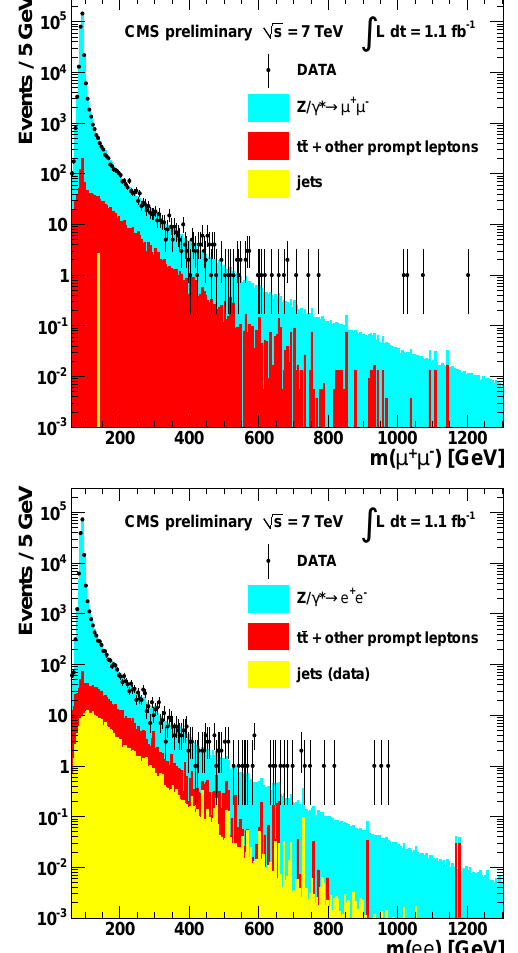
Fig. 3. Invariant mass spectrum of µ + µ − (top) and ee (bottom) events. Data is represented by points with error bars. The uncer- tainties on the data points (statistical only) represent 68% confi- dence intervals for the Poisson means. The filled histograms rep- resent the expectations from SM processes.